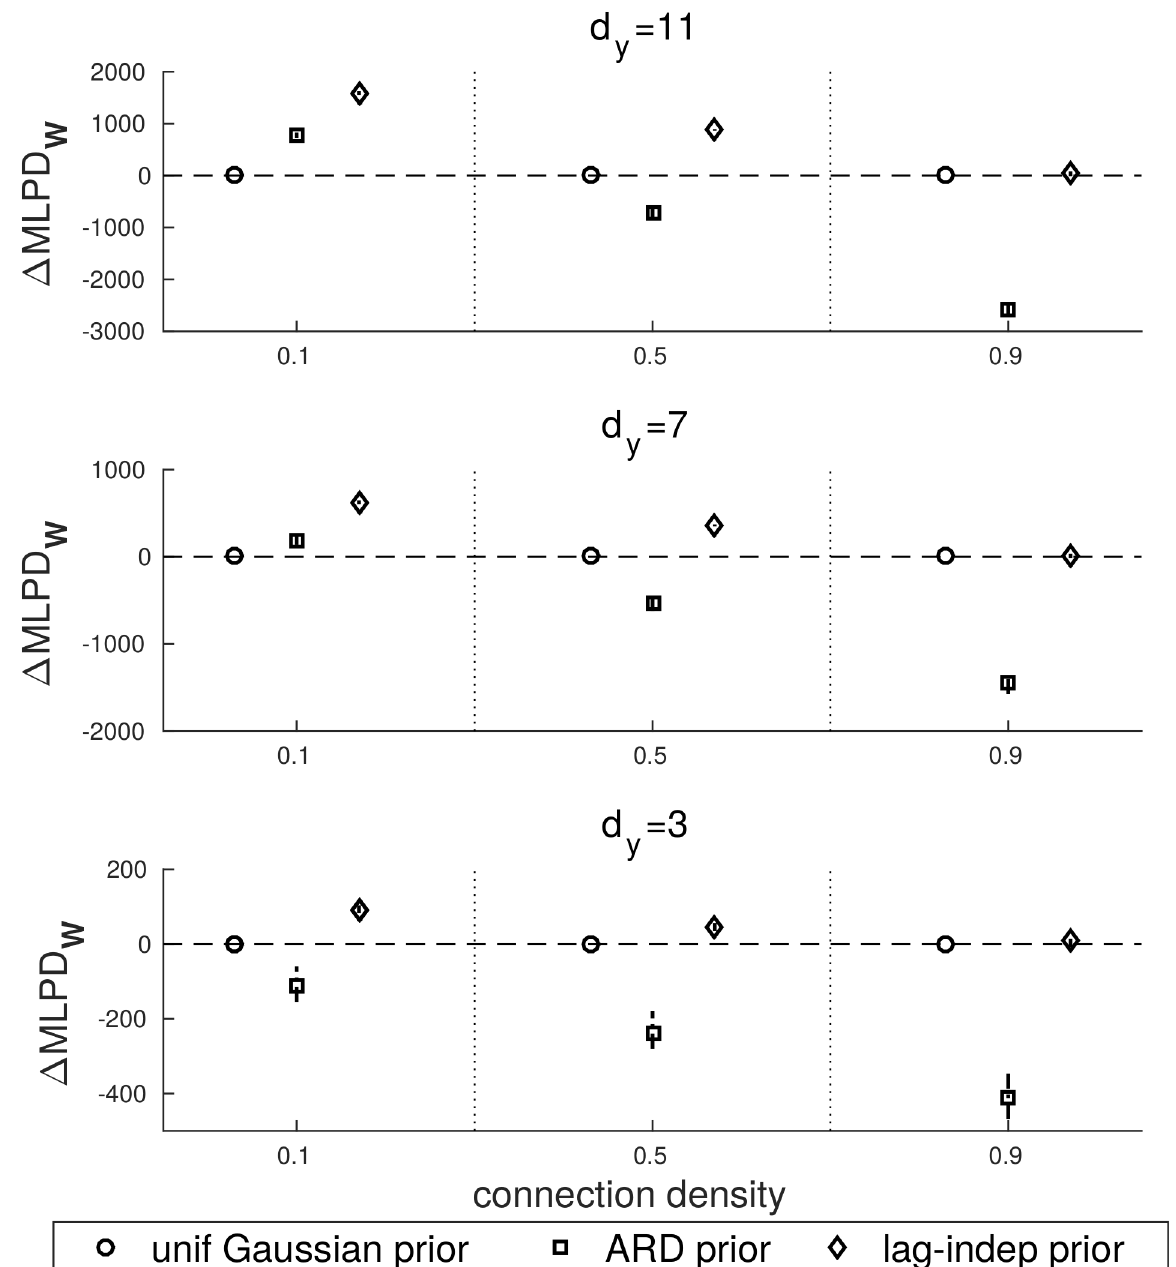
Fig 3. Δ MLPD computed with respectto the uniform Gaussian prior and evaluated on the coefficient